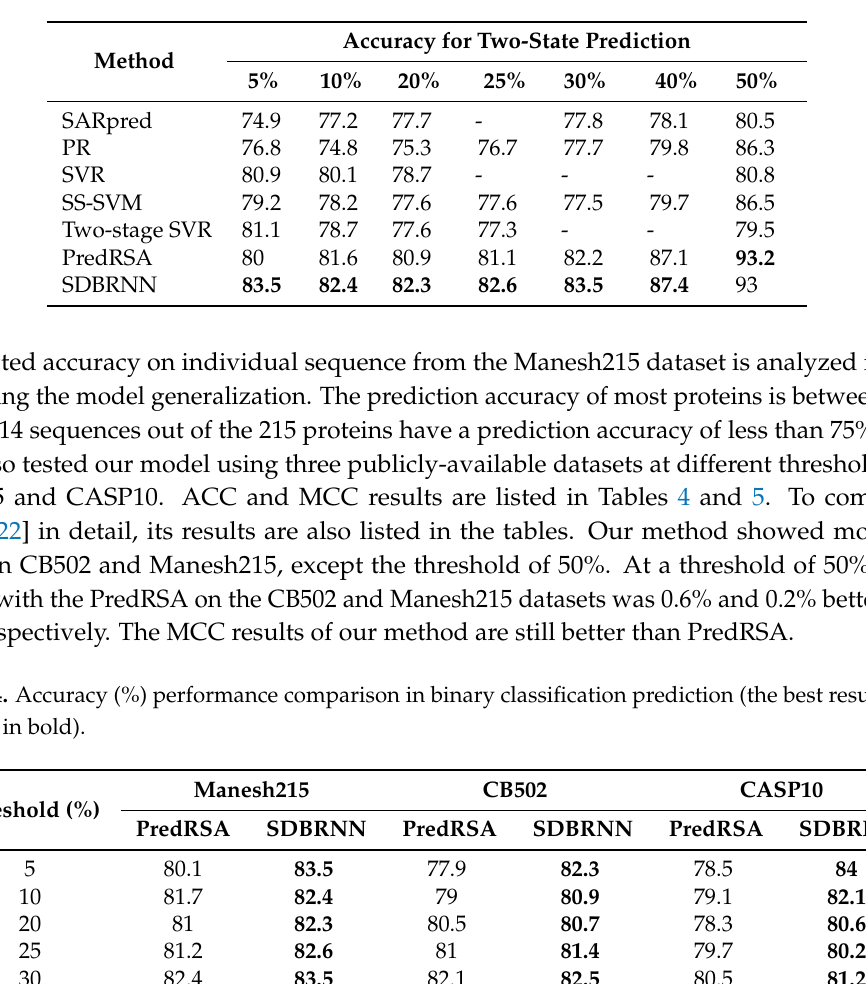
Table 3. Binary classification prediction comparison between our method and other reported methods with different thresholds on the Manesh215 dataset.